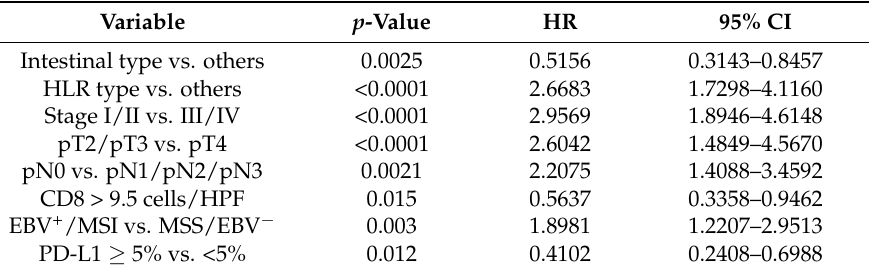
Table 3. Univariate analysis of survival